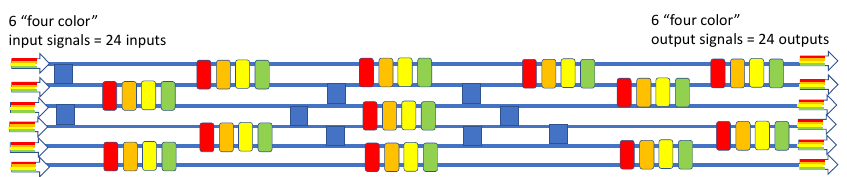
Figure 12. Block diagram of the 6 × 6 × 4λ wavelength-selective switch in six stages.